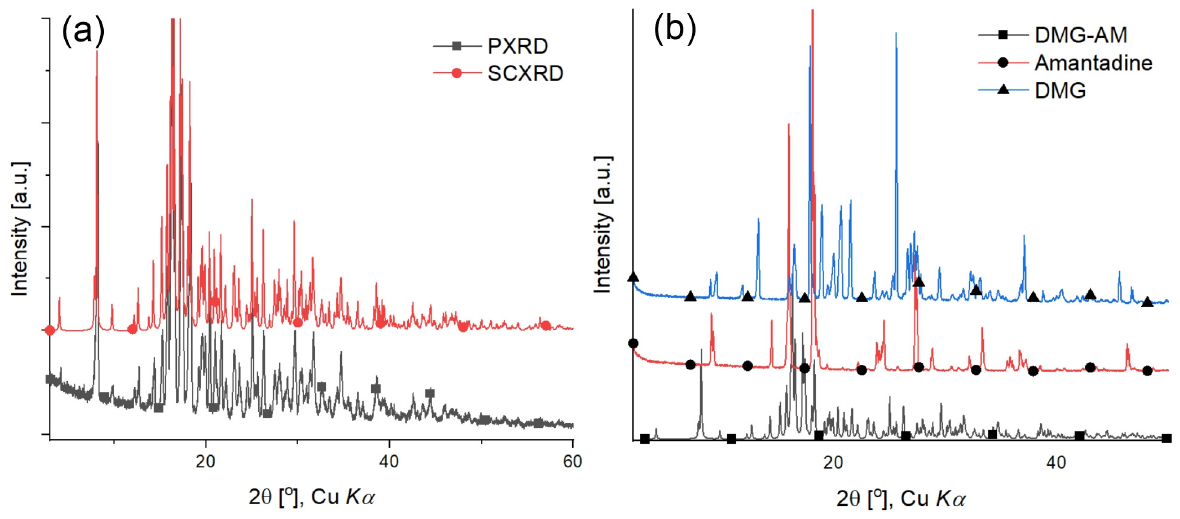
Figure 6. Comparison of: ( a ) the Powder X-ray diffraction pattern (red) versus single crystal X-ray diffraction pattern (generated via Mercury software [35], blue) for DMG-Am; and ( b ) comparison of the PXRD of the starting compounds AM and DMG and DMG-Am.